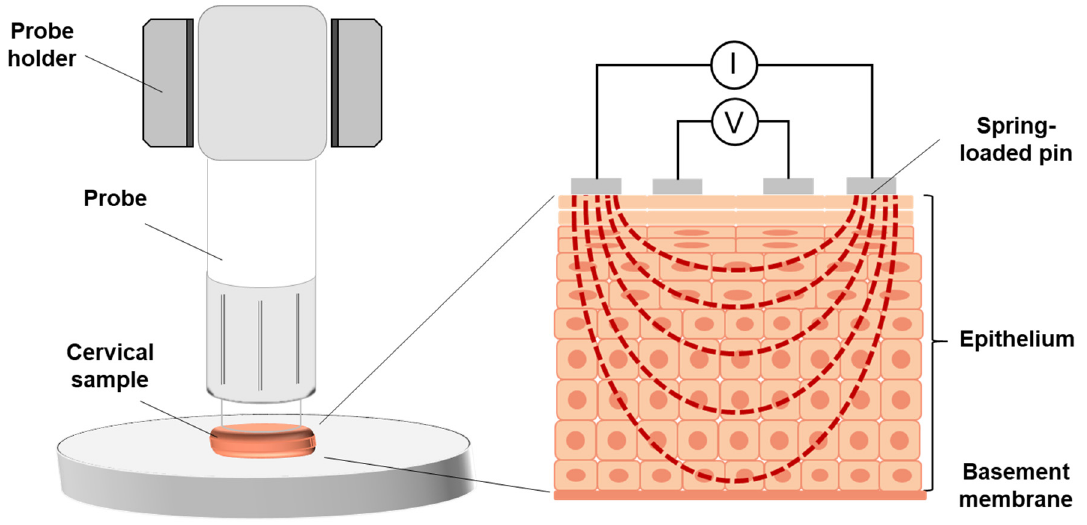
Figure 3. Schematic representation of the experimental setup.